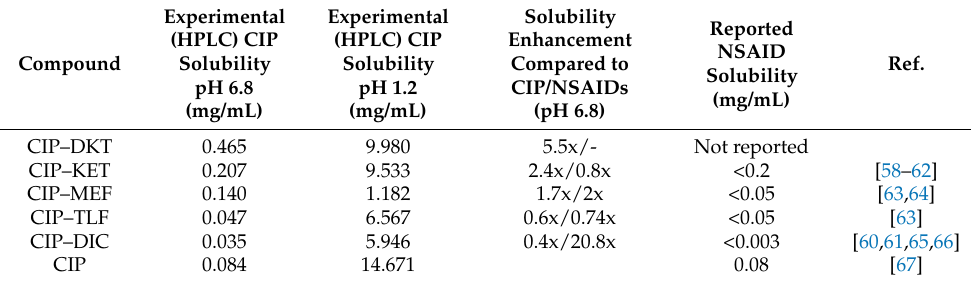
Table 3. Solubility of the molecular salts determined with HPLC analysis.